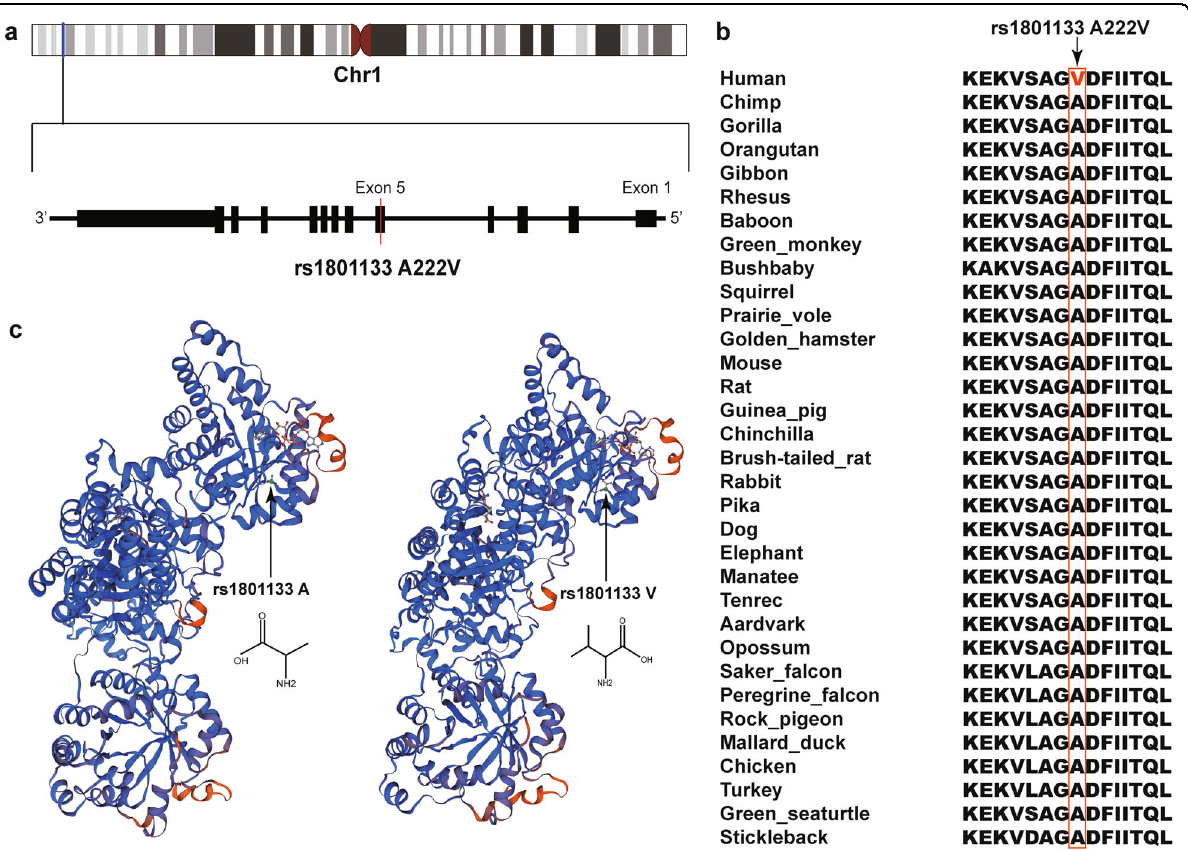
Fig. 3 Genomic location of rs1801133 and the 3D structure of MTHFR. a rs1801133 is located in the fi fth exon of MTHFR . b rs1801133 is located in an evolutionary highly conserved genomic region. The amino acid encoded by rs1801133 was Ala in most of the species. However, a new amino acid (Val) has emerged in humans. c The 3D structure of MTHFR with different amino acids at